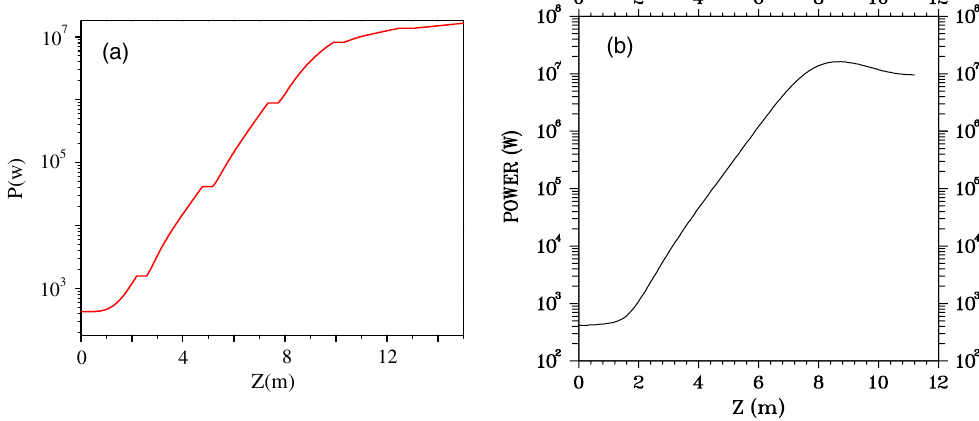
FIG. 12. Main harmonic power evolution: (a) GENESIS 3D simulation; (b) PROMETEO 1D